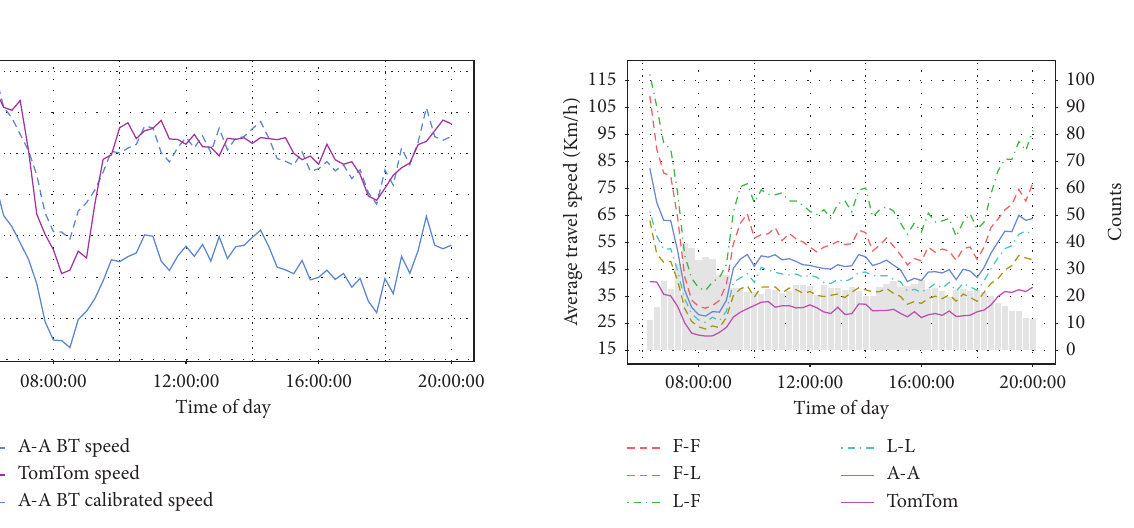
Figure 10: The comparison of five BTaverage speeds and TomTom average speed of link